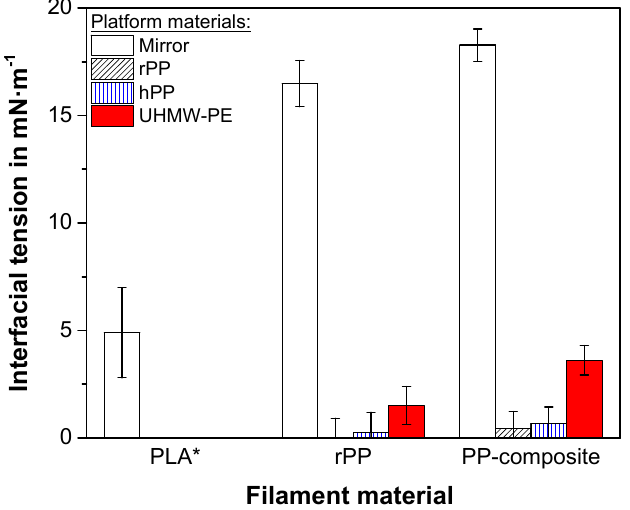
Figure 3. Interfacial tension between the four platform material options and the filaments investigated. The interfacial tension for poly(lactic acid) (PLA) on the mirror, assigned by an asterisk, was measured for the settings in which ideal adhesion was achieved. Hence, it represents a measurement for a platform temperature of 70 ◦ C, taken from Ref. [21], and serves as a reference value for the other material combinations. All other values were obtained at room temperature.